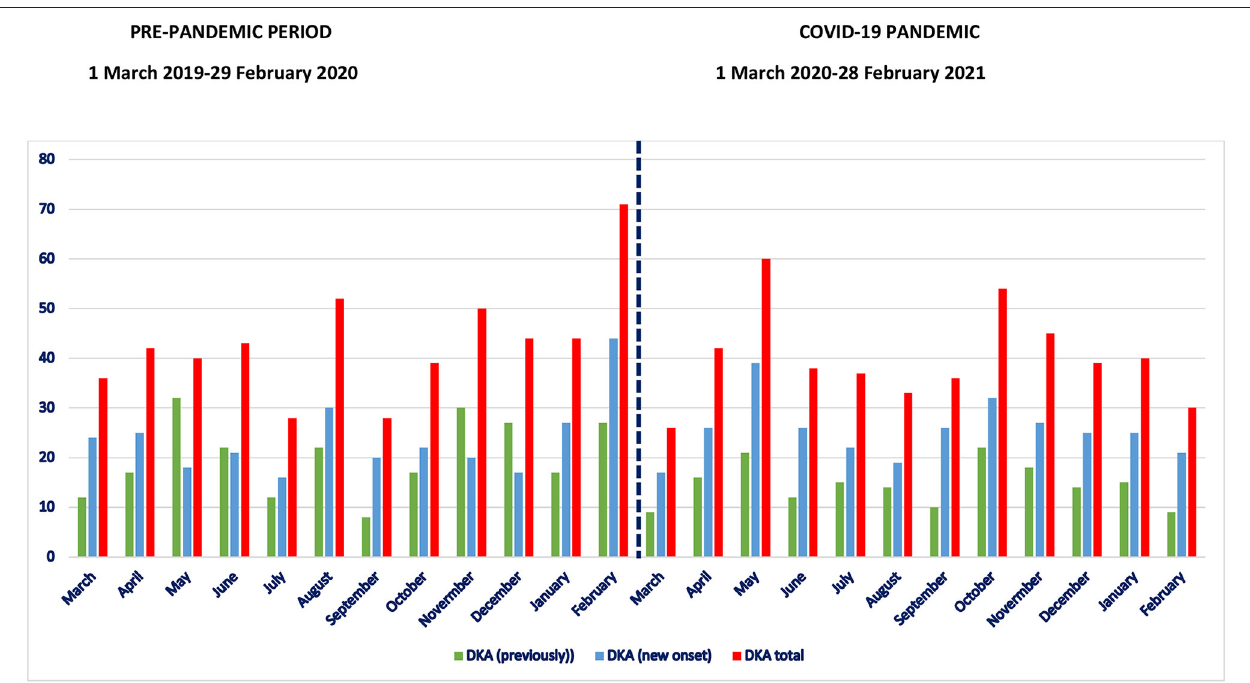
FIGURE 1 | Number of children with diabetic ketoacidosis (red), number of previously type 1 diabetic children with DKA (green) and DKA among children with new onset type 1 diabetes (blue) during the pre-pandemic and COVID-19 pandemic period.